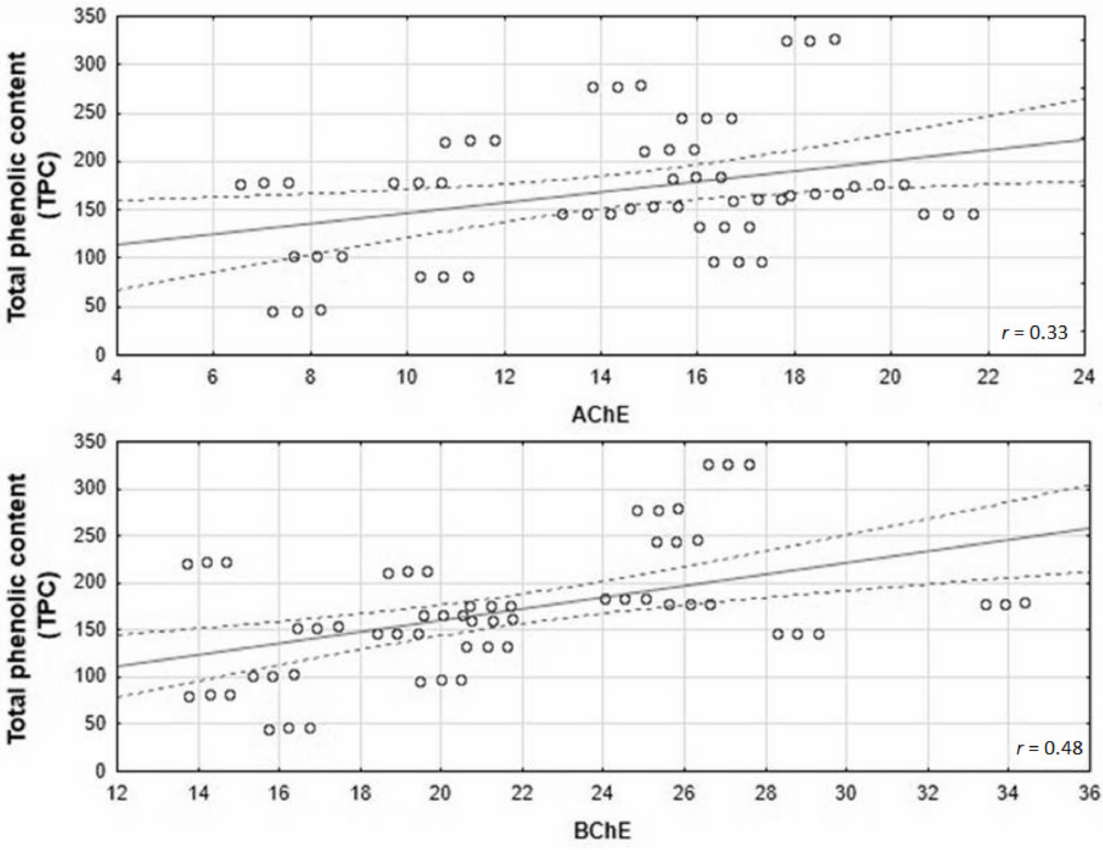
Figure 4. Correlation between anti-AChE activities and TPC of the studied honeys. R-Pearson’s correlation coefficient ( r